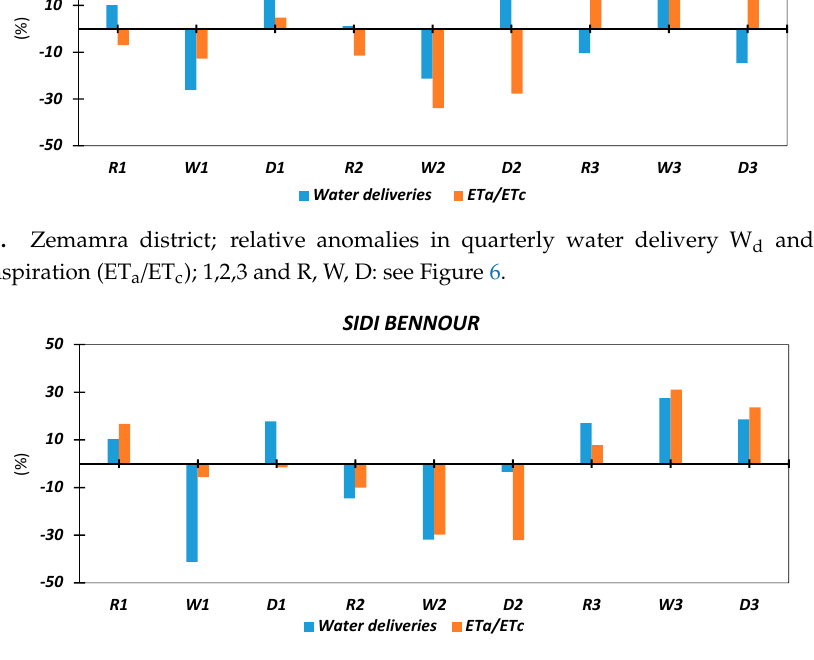
Figure 11. Sidi Bennour district; relative anomalies in quarterly water delivery W d and relative evapotranspiration (ET a /ET c ); 1,2,3 and R, W, D: see Figure 6.